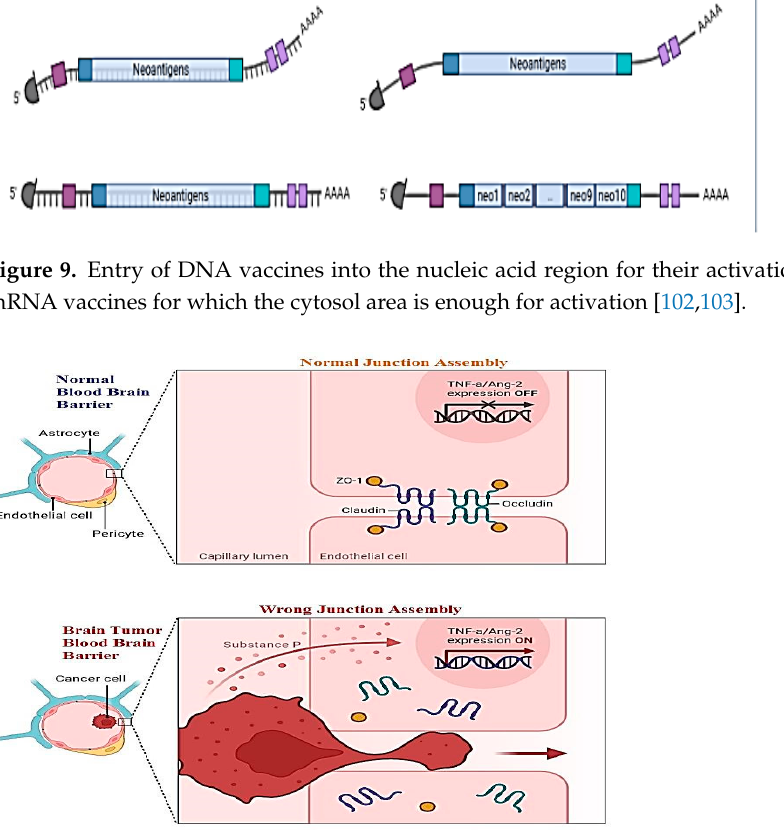
Figure 9. Difference between normal blood–brain barrier showing normal occluding and claudin protein junctions, and brain tumor blood–brain barrier disturbing occluding and claudin by invading the normal cell membrane [83,98,104].